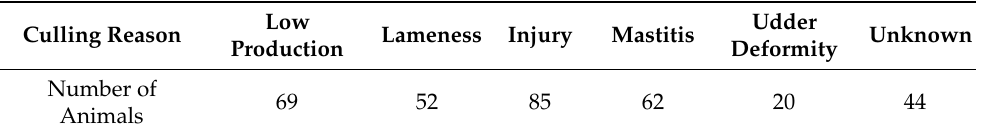
Table 2. Number of animals that were simulated to be removed from the herd due to culling for each of the listed reasons during a 365-day simulation of a 1000-cow herd in the RuFaS